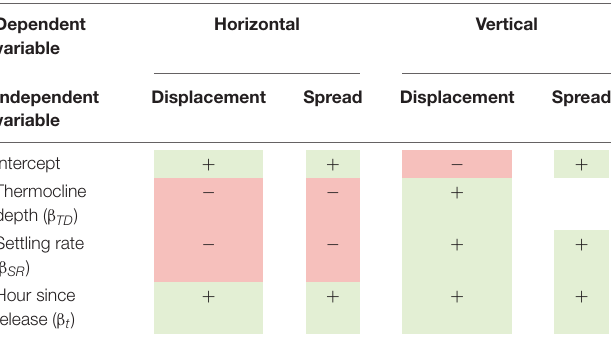
TABLE 1 | Summary of statistical